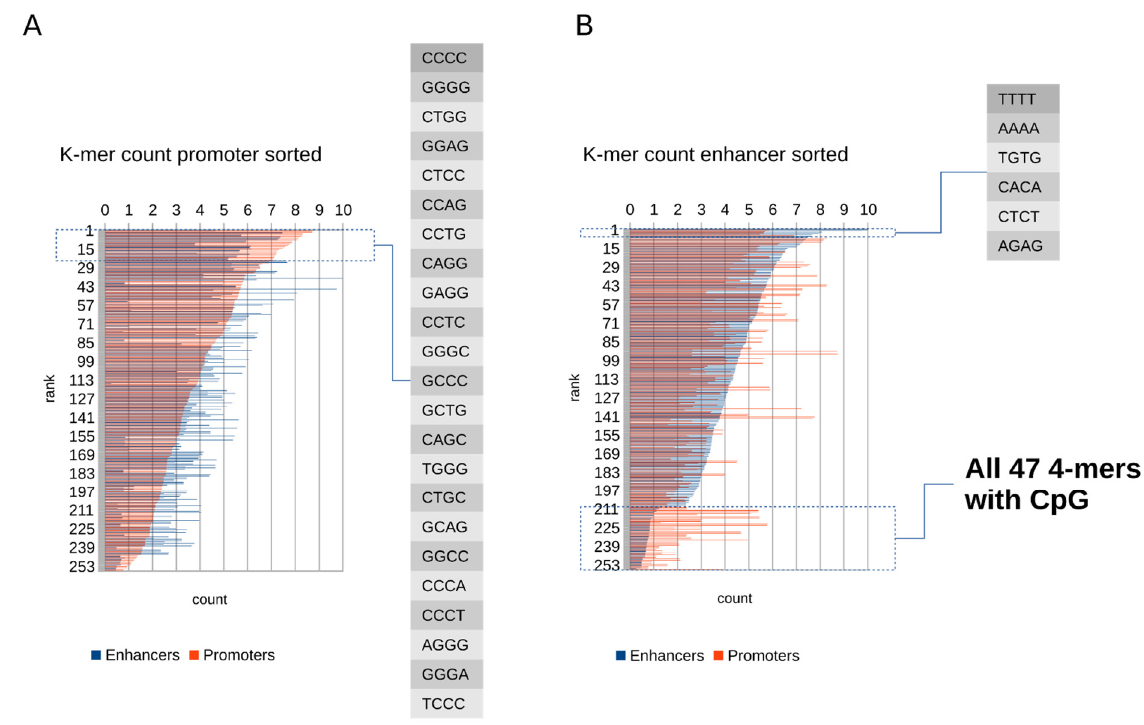
Figure 1. Ranked average k-mer (k = 4) counts in promoters and in enhancers. ( A ) Average k-mer counts in promoters and in enhancers ranked on their count in promoters. The dotted rectangle marks the top 23 k-mers with the highest counts in promoters that were also higher than their counts in enhancers. ( B ) Average k-mer counts in promoters and in enhancers ranked on their count in enhancers. The upper dotted rectangle marks the top six k-mers with the highest counts in enhancers that were also higher than their counts in promoters. The corresponding data with the k-mer sequences are provided as Table S1.